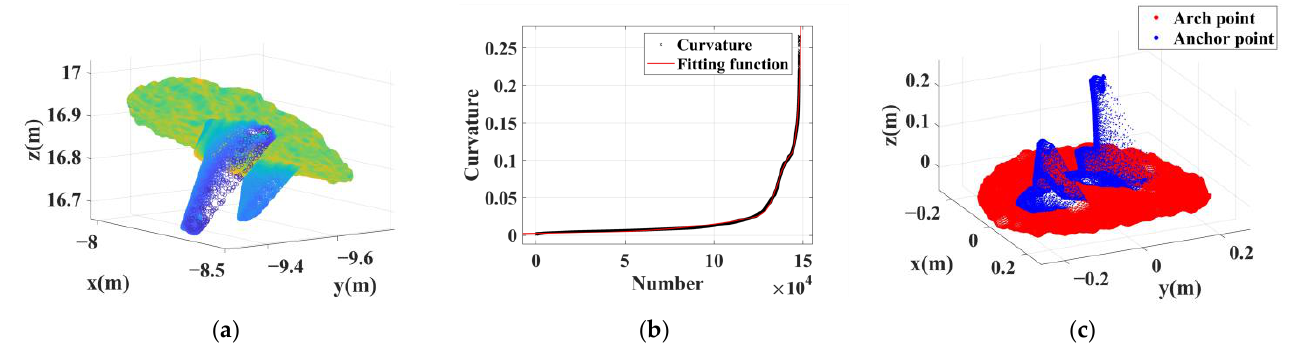
Figure 12. Extraction results of two anchor rods in the same cluster. ( a ) Dense point cloud. ( b ) Curvature fitting results. ( c ) Extraction results; red points belong to the arch roof, and the blue points belong to the anchor rod.